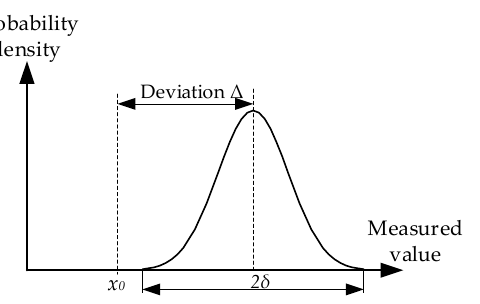
Figure 9. Characteristics of simultaneous existence of systematic error and random error.